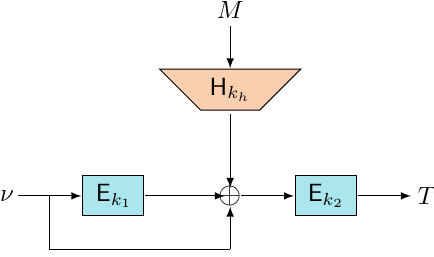
Figure 1.1: Encrypted Wegman-Carter with Davies-Meyer Construction.